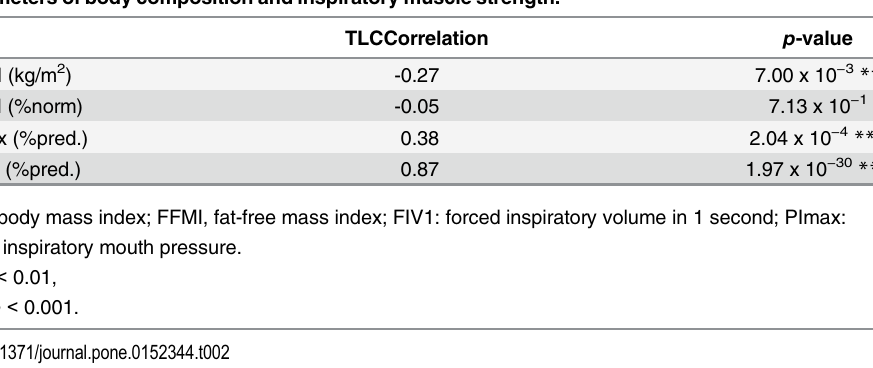
Table 2. Pearson ’ s correlation coefficients for the relation between total lung capacity (TLC) and parameters of body composition and inspiratory muscle strength.